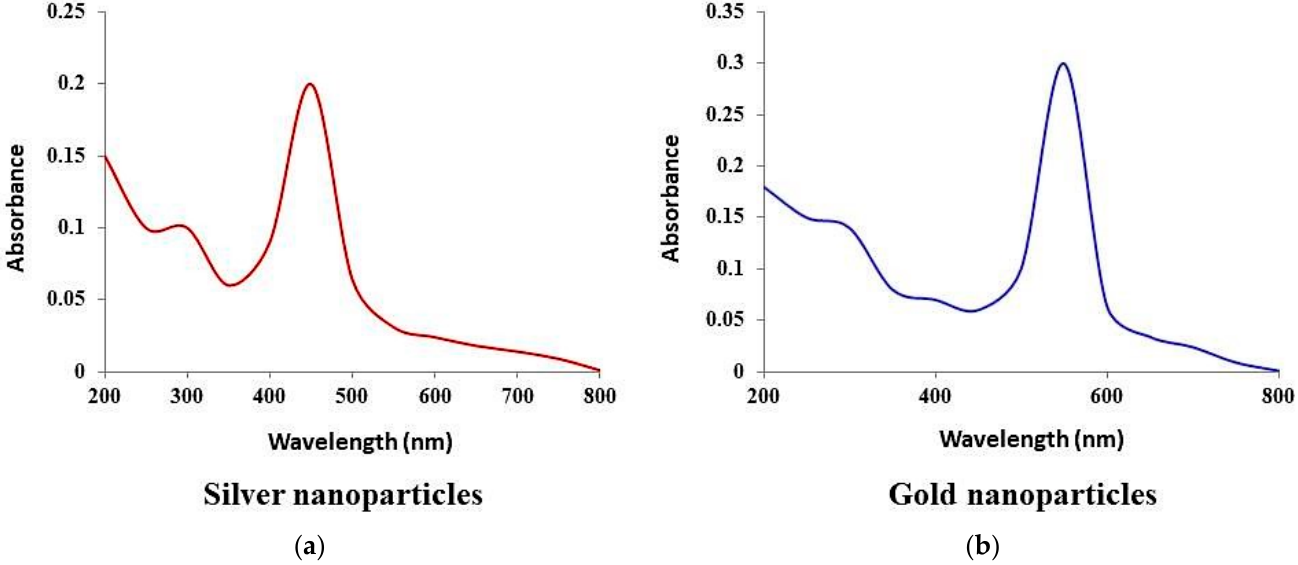
( a ) ( b ) Figure 6. UV − Vis spectrum of plasmon resonance of nanoparticles synthesized by Thraustochytrium kinnei : ( a ) silver; ( b ) gold.